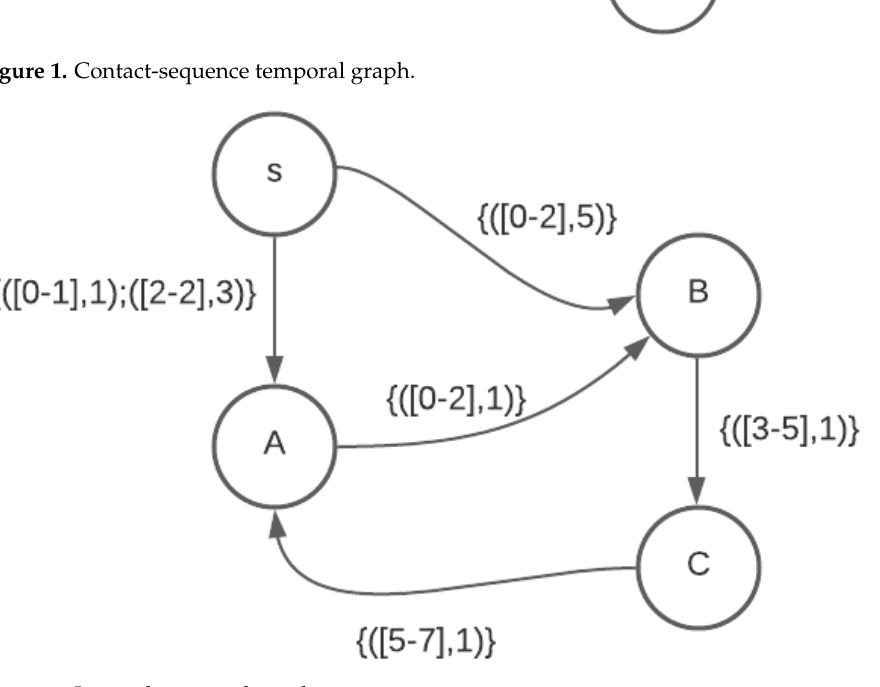
Figure 2. Interval-temporal